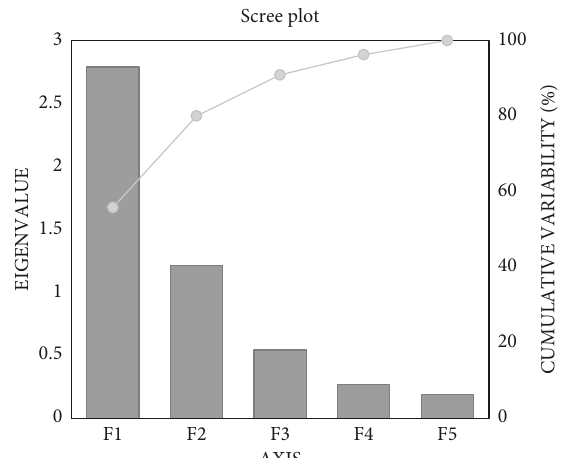
Figure 1: Scree plot showing eigenvalue and cumulative variability of studied parameters.